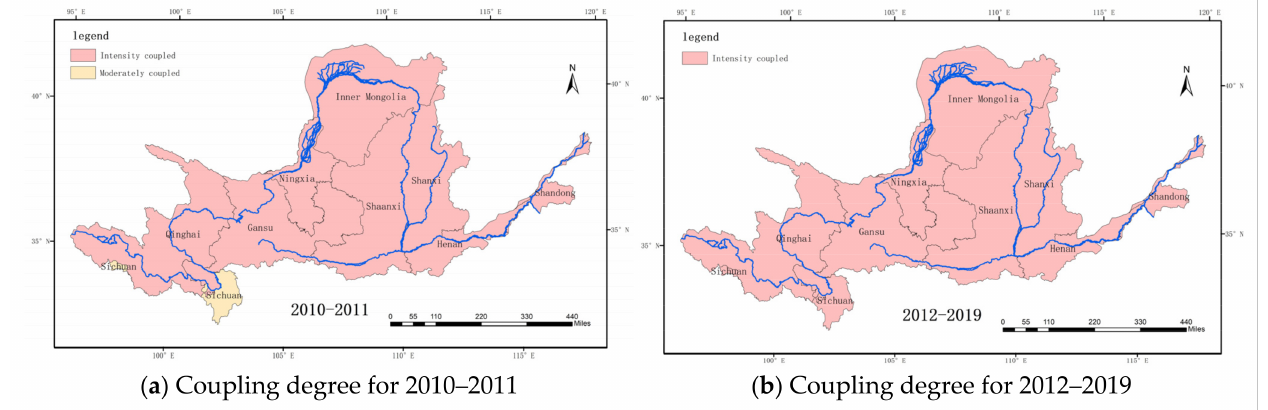
Figure 8. Spatial distribution of the coupling degree of the economy and ecology in the Yellow River